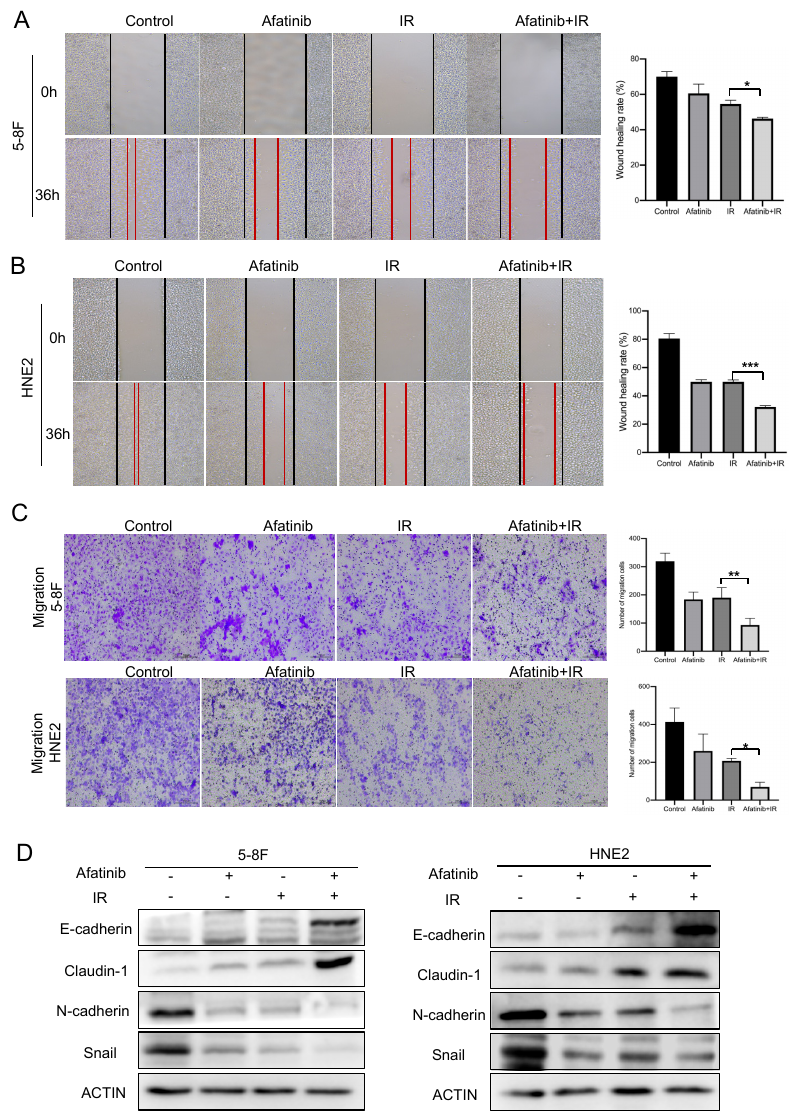
Figure 5. Afatinib combined IR treatment inhibited the EMT process. ( A , B ) 5-8F ( A ) and HNE2 cells ( B ) were treated as indicated and cell migration was measured by wound healing assay. ( C ) 5-8F and HNE2 cells were treated as indicated and cell migration was assessed by transwell assay without Matrigel. Cellular migration was plotted as the average number of cells in three different areas. ( D ) 5-8F and HNE2 cells were treated as indicated, WCLs were prepared at 24 h post-treatment and analyzed by immunoblotting with representative EMT marker antibodies. * denotes p < 0.05, ** denotes p < 0.01, *** denotes p < 0.001. Error bars represent ±SD of triplicate experiments.